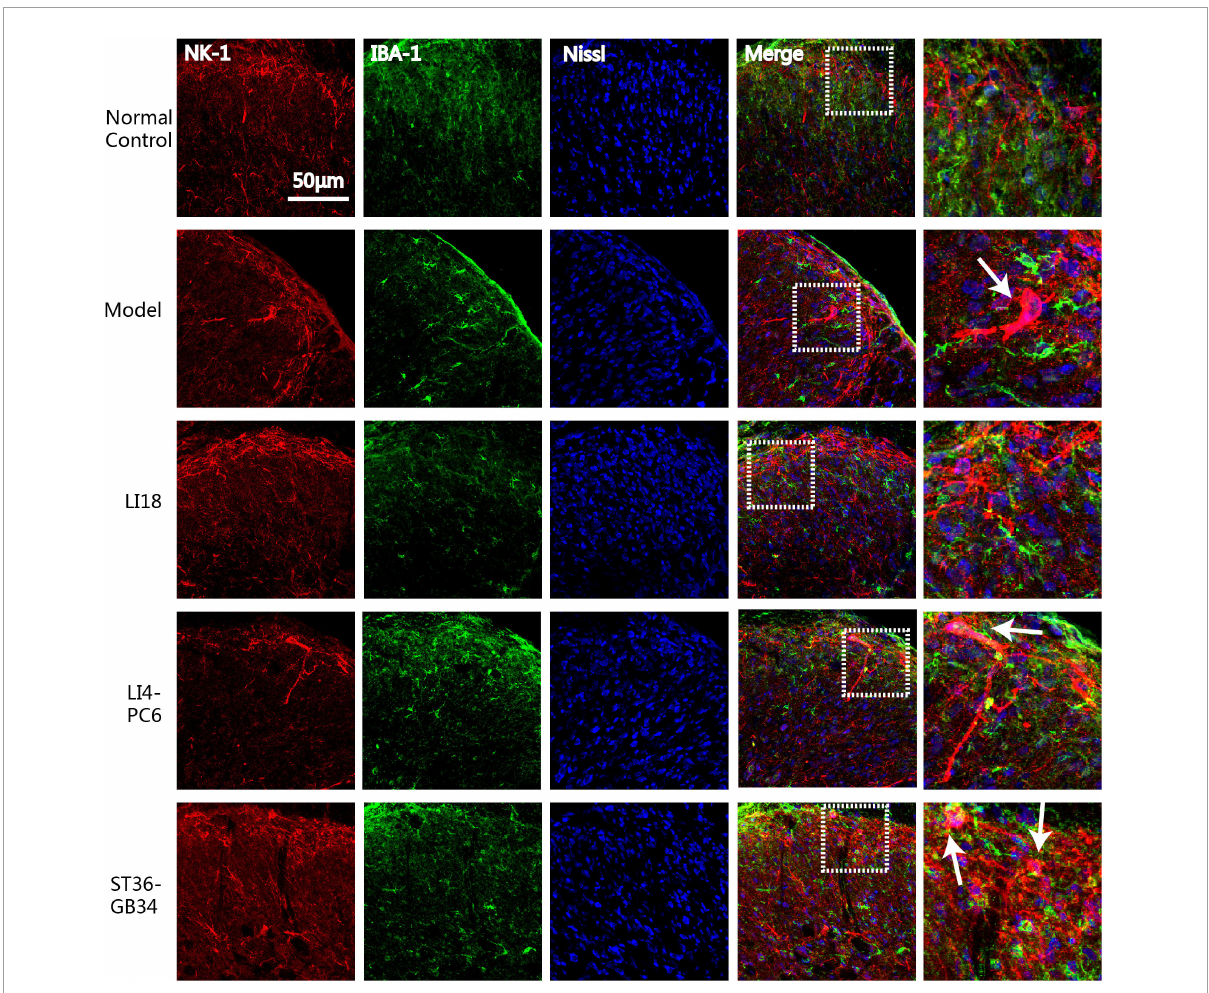
FIGURE5 Confocal micrographs showing the expression of neurokinin-1 receptor (NK-1R) (red) and ionized calcium-binding adapter molecule 1 (Iba-1) (green) in the superficial dorsal horns (DHs) of the cervical spinal cord in different groups at 24 h after neck incision. Nissl staining (blue) shows the nucleus of cells. The scale bar is 50 µ m. The white arrows indicate the NK-1 immunoreaction (IR) (red) positive neurons which are gathered around by the activated microgliacytes (green) in the DHs of cervical spinal cord.